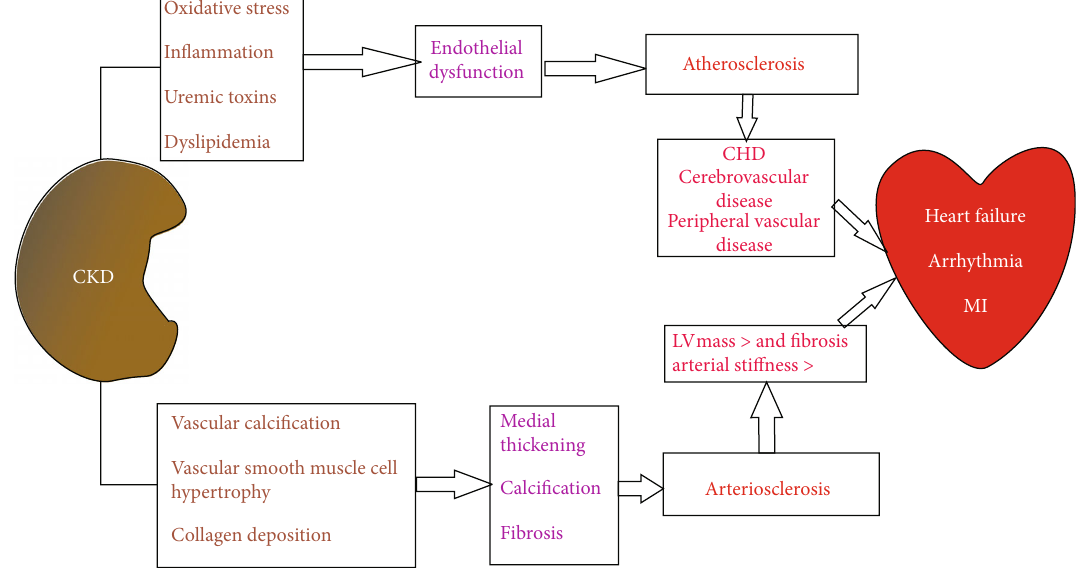
Figure 1: The pathophysiology of atherosclerosis and arteriosclerosis in patients with CKD. CHD: coronary heart disease; CKD: chronic kidney disease; LV: left ventricle; MI: myocardial